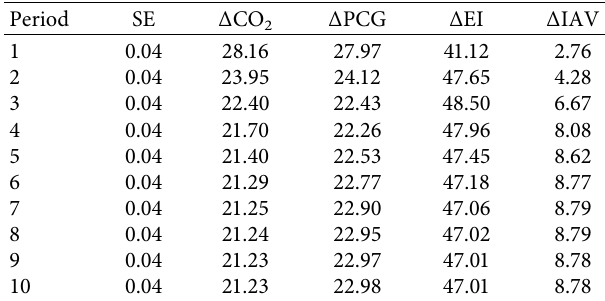
Table 11: Variance decomposition of Δ CO